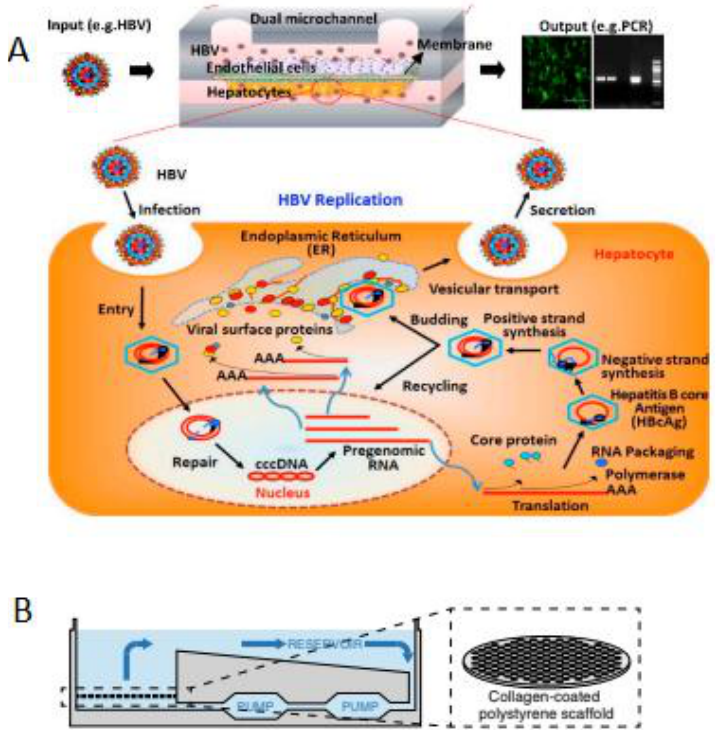
Figure 4. Modeling hepatitis infections using microfluidic devices. ( A ) Human Liver Sinusoid on a Chip design to infect the hepatocytes within the device with HBV virus [74], adapted with permission from Kang et al., 2017. Copyright 2017 by Kang et al.; licensee MDPI, Basel, Switzerland. ( B ) 3D microfluidic liver culture, grown in bioreactor, where circulation is created using pumps [76], adapted with permission from Ortega-Prieto et al., 2018, Copyright © Ortega-Prieto et al., 2018.